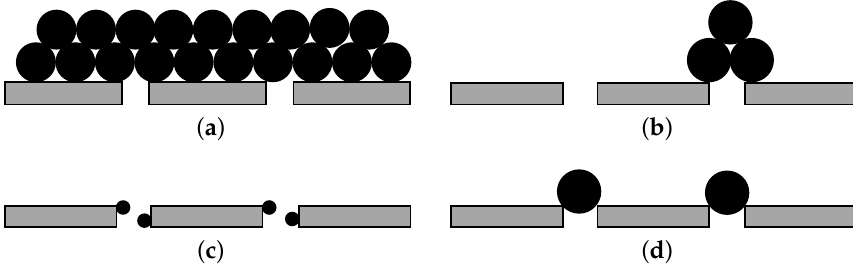
Figure 2. Graphical representation of the four classical fouling models developed by Hermia. ( a ) Cake filtration model ( n = 0); ( b ) intermediate blocking model ( n = 1); ( c ) internal blocking model ( n = 3/2); ( d ) complete blocking model ( n =